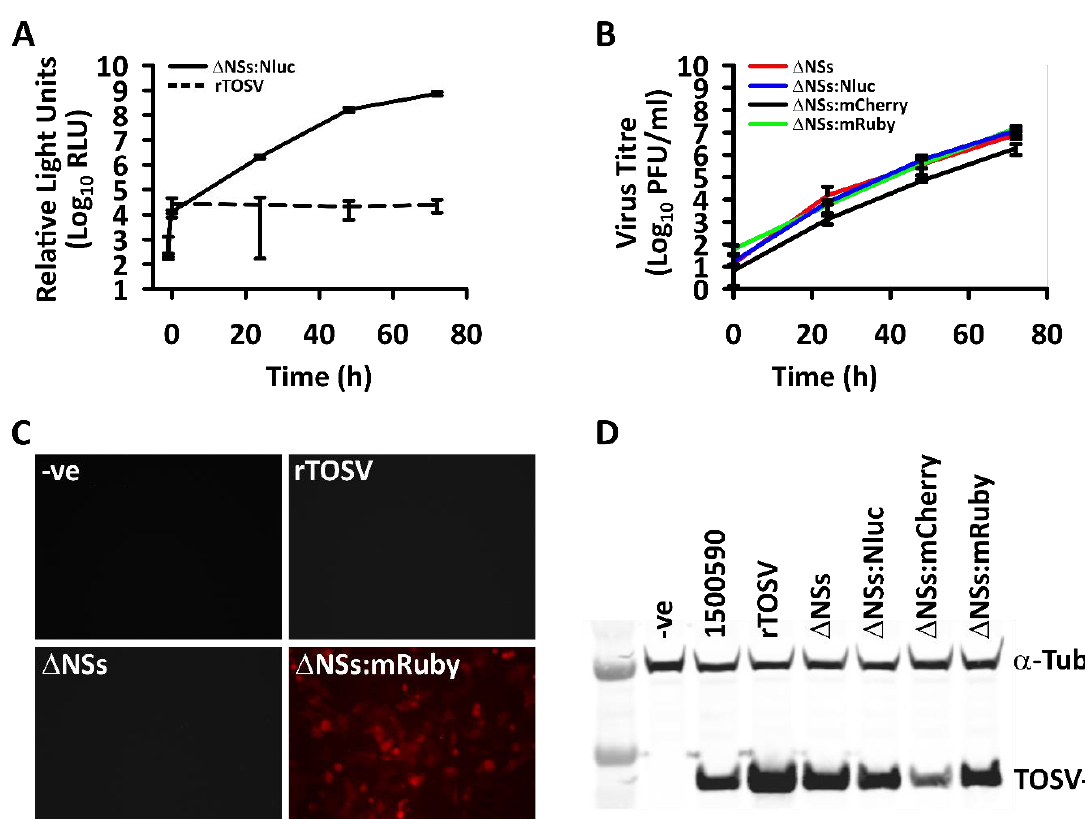
Figure 5. Generation of TOSV NSs deletion mutants. ( A ) Replacement of the NSs ORF with NLuc allows for measurements of viral replication within the A549 NPro cells. rTOSV is shown as a baseline control to ensure the light readings reflect NLuc activity from the replicating, reporter gene expressing virus. RLU, relative light units. The luciferase assay was repeated twice independently, N = 3; ( B ) Replication of TOSV NSs deletion/replacement mutants in A549 NPro cells (MOI of 0.1). Each time course was repeated twice independently, N = 3; ( C ) When NSs was replaced with mRuby, infected cells were clearly visible in the red fluorescence channel (mCherry is identical to mRuby), the scale bar is 200 µm; ( D ) Western blot detection of N protein in BSR cells after 48 h (MOI 0.1), tubulin detection with anti α-tubulin to show loading control. Error bars show standard deviations.